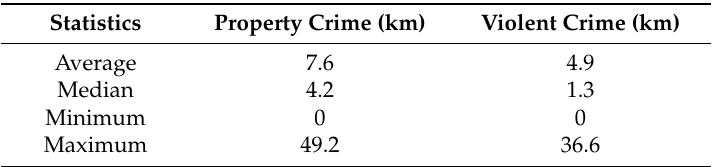
Table 3. Distance to